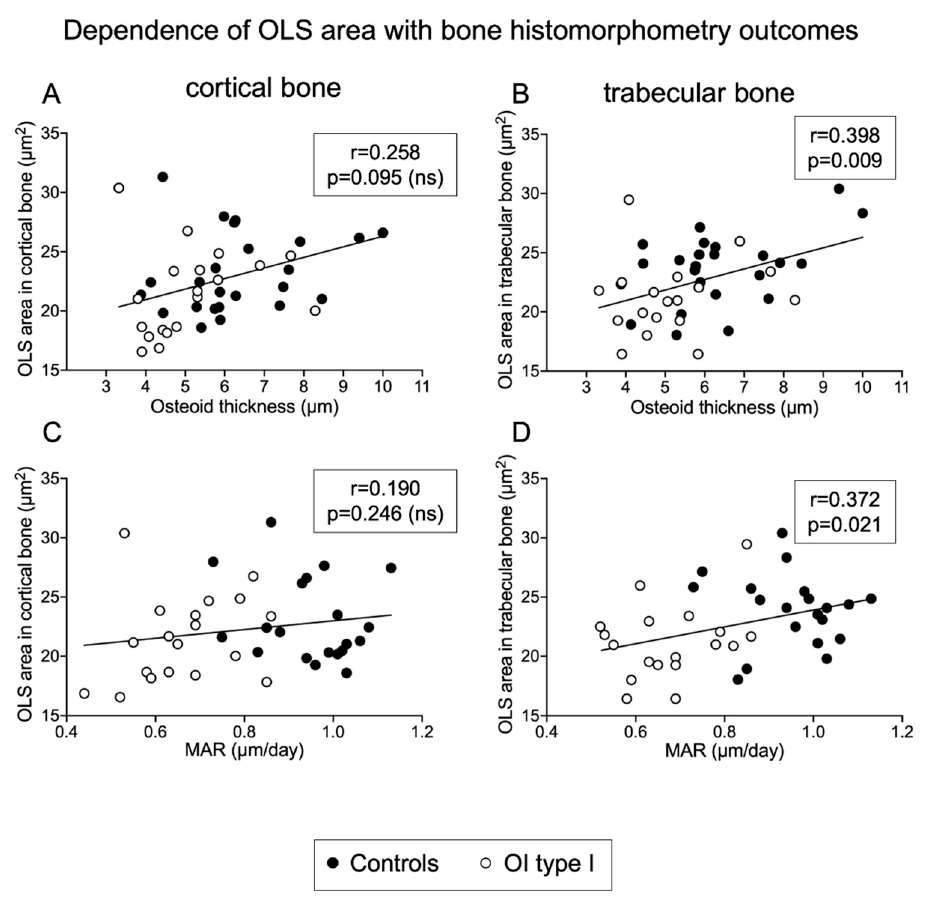
Figure 6. Dependency of OLS area with bone histomorphometry outcomes (total sample analysis): OLS area is positively correlated with osteoid thickness ( A , B ) and MAR ( C , D ), two parameters reflecting osteoblast function.